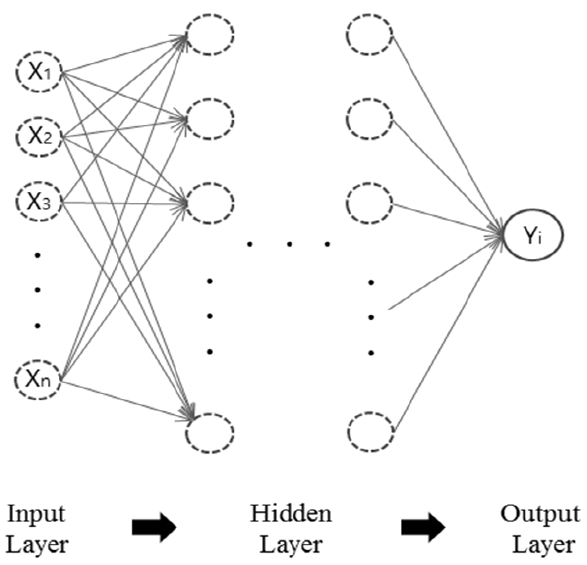
Figure 2. Structure of the multi-layer feed-forward network (X: inputs, Y: output).